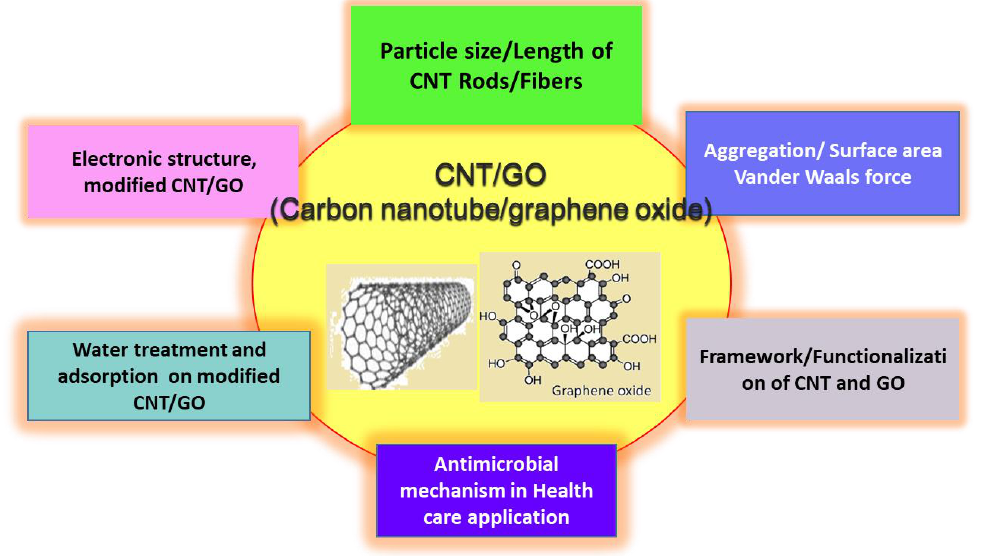
Figure 4. Effect of preparation strategy upon functionalization, physico chemical property, and its potential application in various field [60] (modified image reproduced with permission).